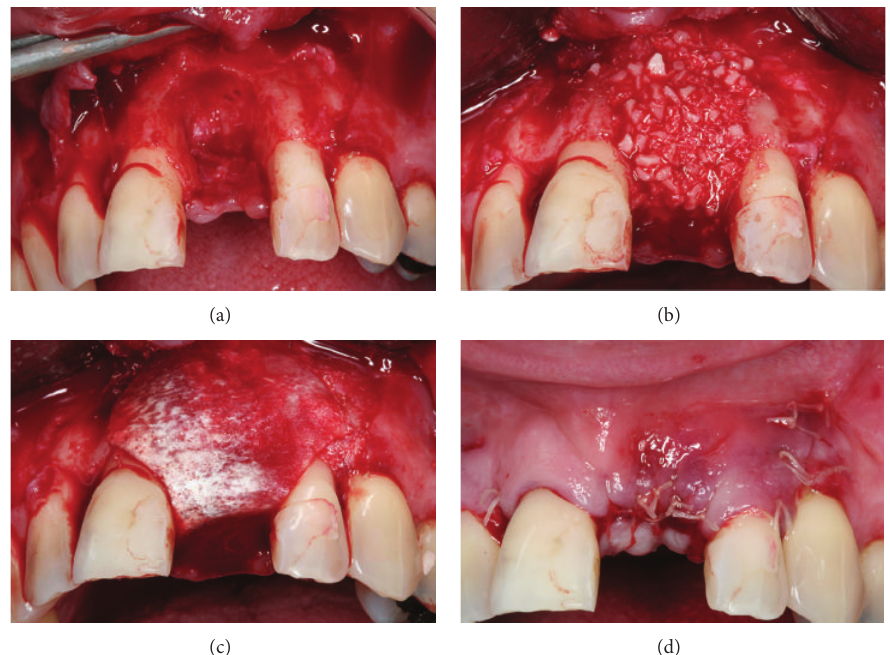
Figure 3: Guided bone regeneration with xenogenous bone graft and membrane barrier followed by a simple suture.